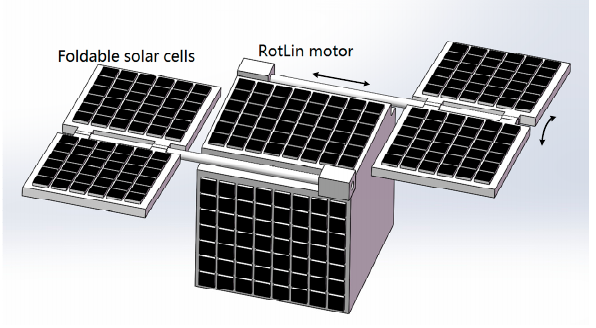
Figure 23. New foldable solar generation with the designed RotLin motor.